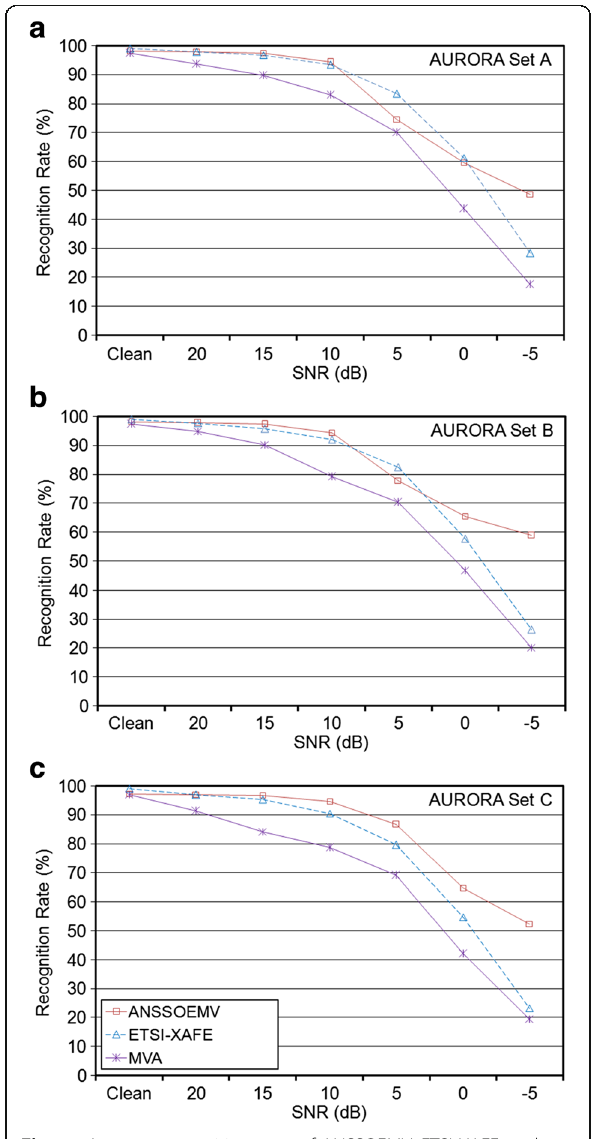
Fig. 11 Average recognition rates of ANSSOEMV, ETSI-XAFE, and MVA approaches on Aurora 2. a Test set A, b Test set B. c Test set